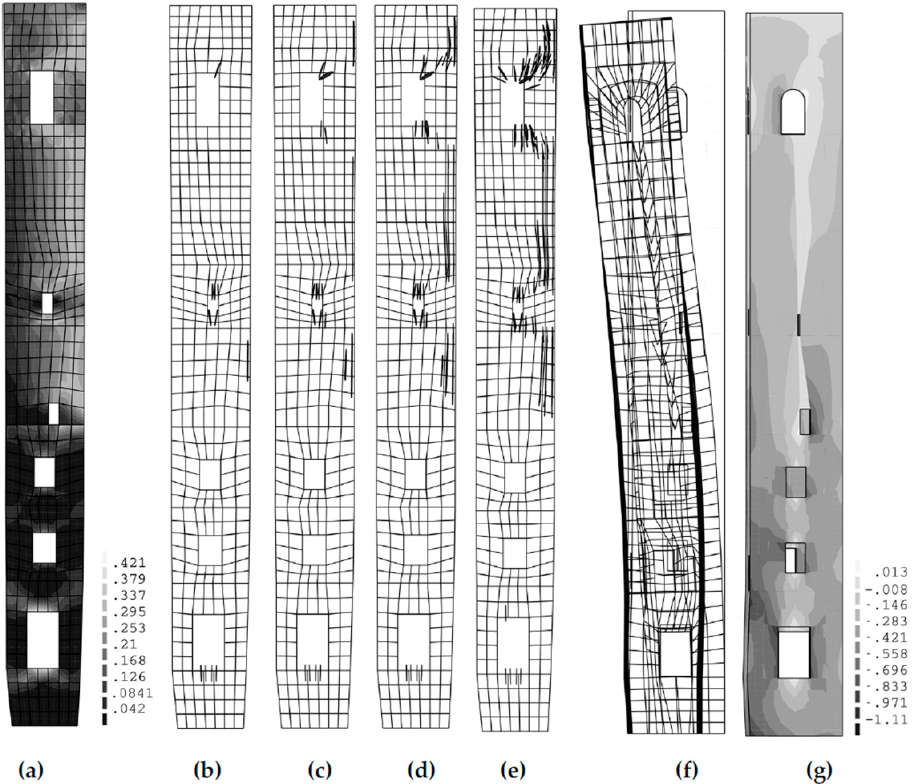
Figure 3. Torre Astesiano: ( a ) internal side of the South wall: principal tensile stress (MPa); ( b – e ) thermally induced crack pattern evolution; ( f – g ) deformed mesh and vertical stresses (MPa) of the damaged model.